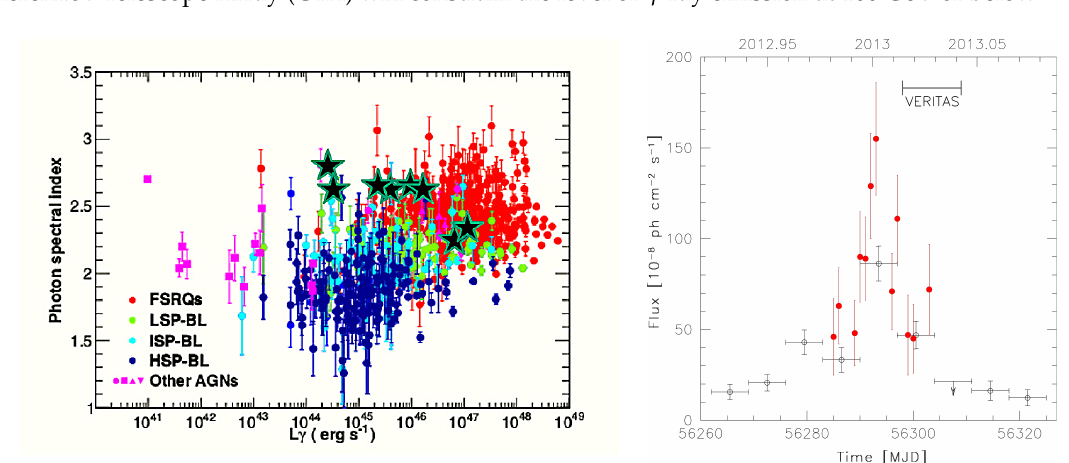
Figure 1. ( Left panel ): Photon index versus γ -ray luminosity of different types of Active Galactic Nuclei (AGN) included in the 3LAC. Black stars represent the values obtained over 7 years for narrow-line Seyfert 1 (NLSy1). Adapted from [20]; ( Right panel ): LAT light curve of PMN J0948 + 0022 in the 0.1–100 GeV energy range during 1 December 2012–31 January 2013 with 7-day time bins. Arrow refers to 2- σ upper limit. Upper limits are computed when TS < 10. Red solid circles represent daily fluxes reported for the periods of high activity. The horizontal line indicates the period of the VERITAS observation. Adapted from